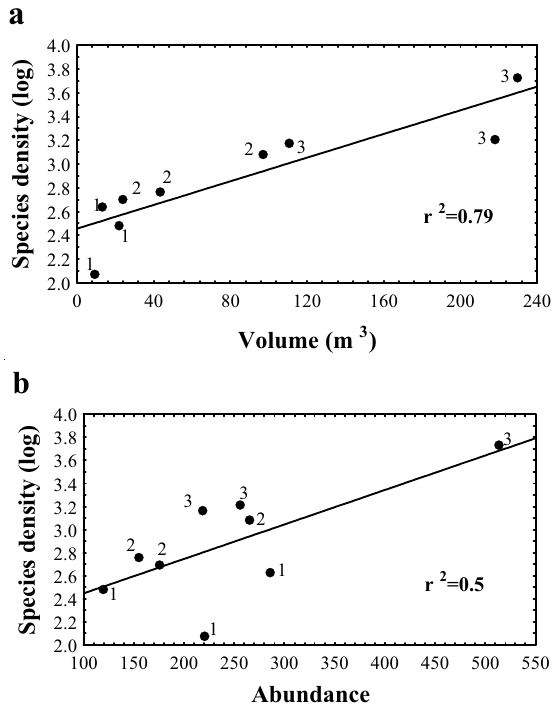
Fig. 2. Relation between fish species density (a), fish abun- dance (b) and water volume (m 3 ) in 100-m stream segments of 1 st , 2 nd , and 3 rd order located in the study areas of Biological Dynamics of Forest Fragments Project, Manaus, Amazonas State. The numbers 1 to 3 refer to the stream